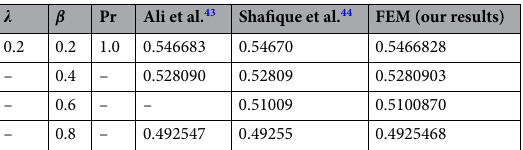
Table 2. Comparison of skin friction involved parameters.